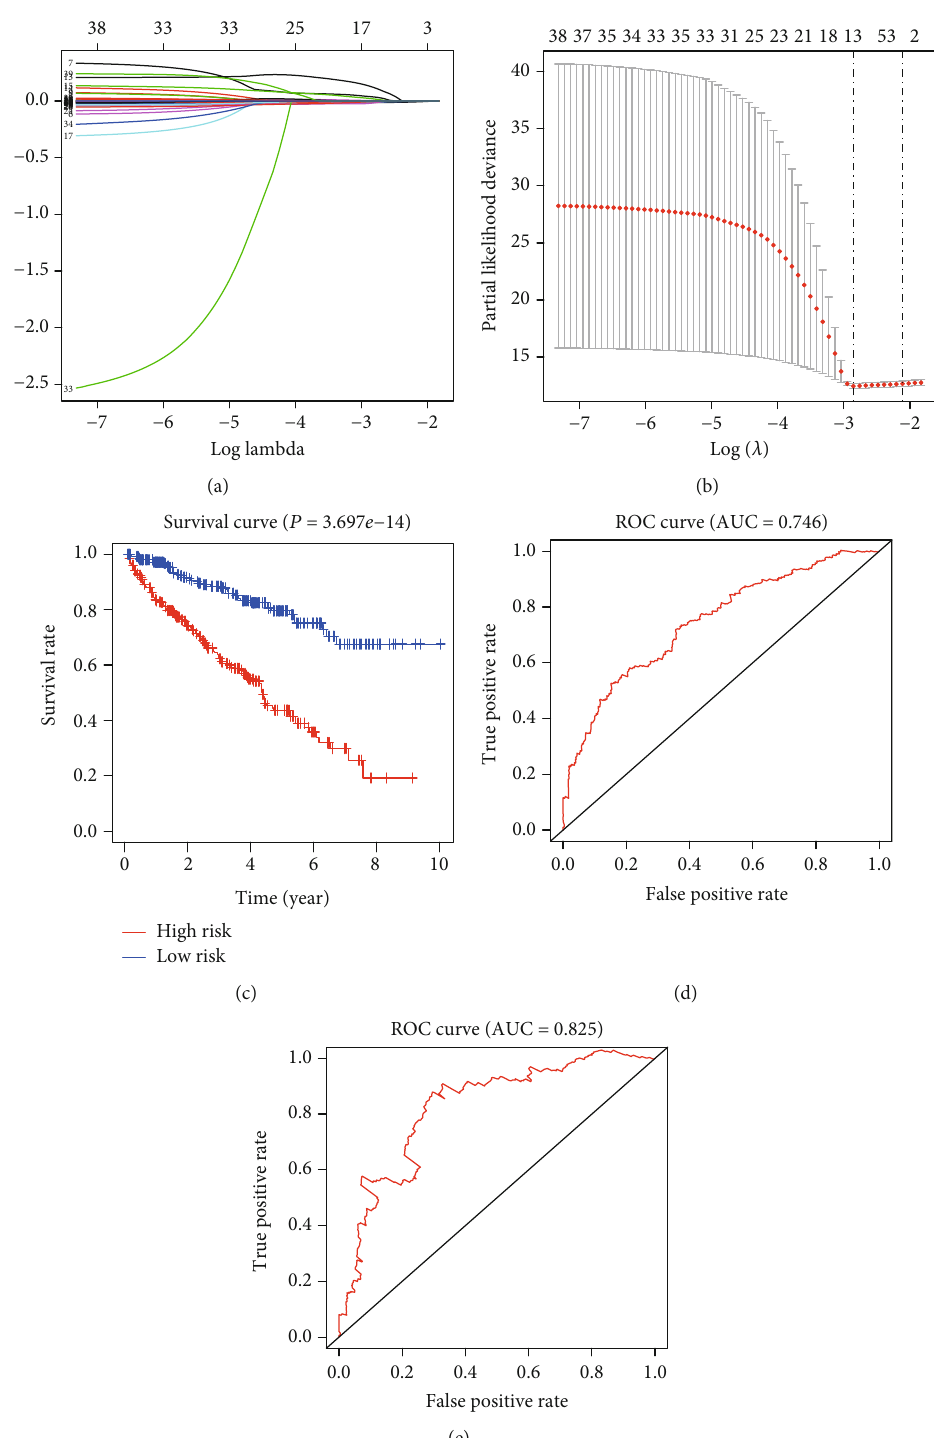
Figure 3: The establishment of the risk model and analysis of its prediction accuracy. (a, b) Target gene selection using LASSO logistic regression. (c) Based on this model, we conducted survival analysis in KIRC. (d) Five-year ROC curve. (e) Ten-year ROC